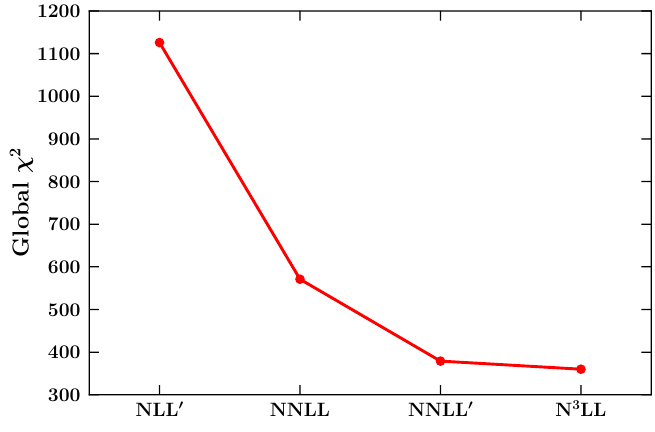
Figure 6 . Graphical representation of table